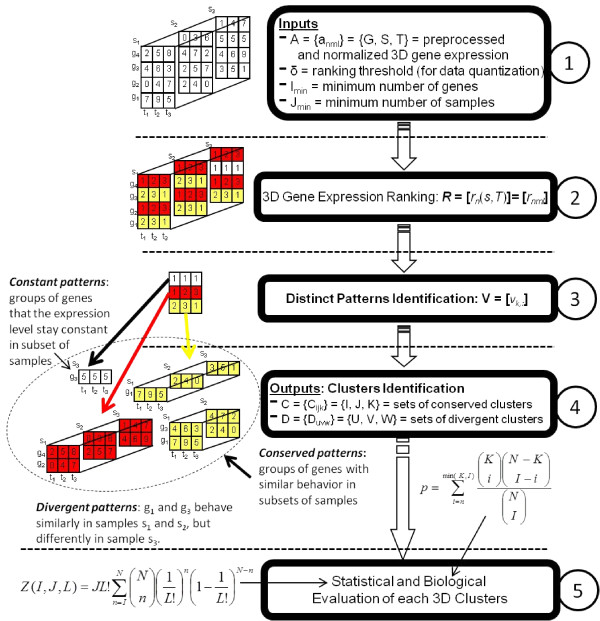
OPTricluster illustration Example illustrating the different steps of the OPTricluster algorithm.